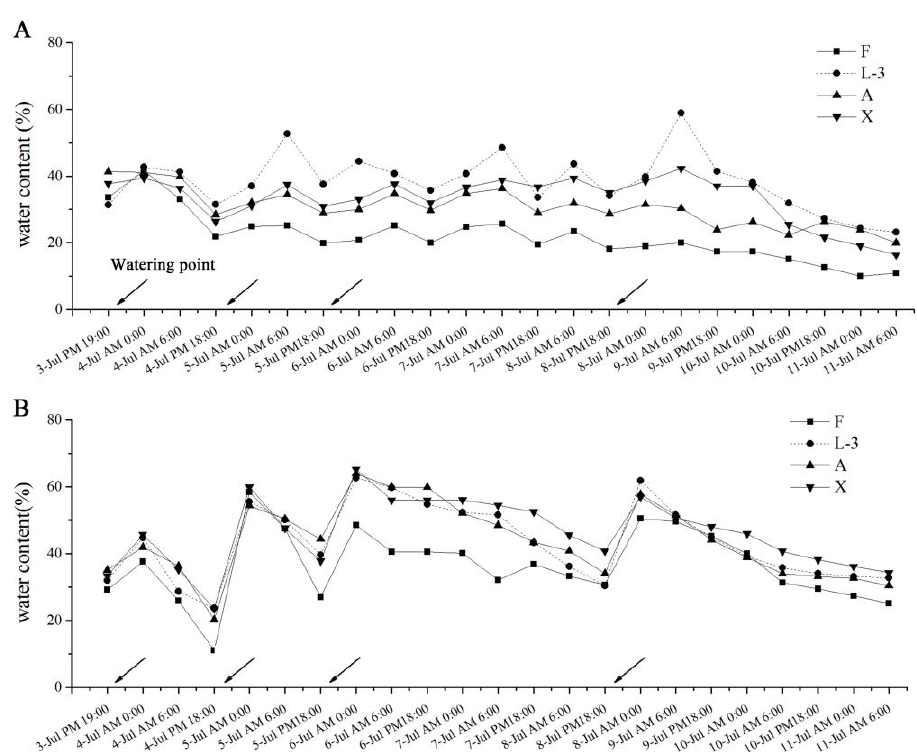
Figure 3. Soil water content under DW (half-irrigation) conditions. ( A ), top pots. ( B ), bottom pots. The arrows indicate the time points of watering. F, L-3, A, and X indicate different potato cultivars. F, Favorita cultivar. L-3, Longshu No.3 cultivar. A, Atlantic cultivar. X, Xindaping cultivar.